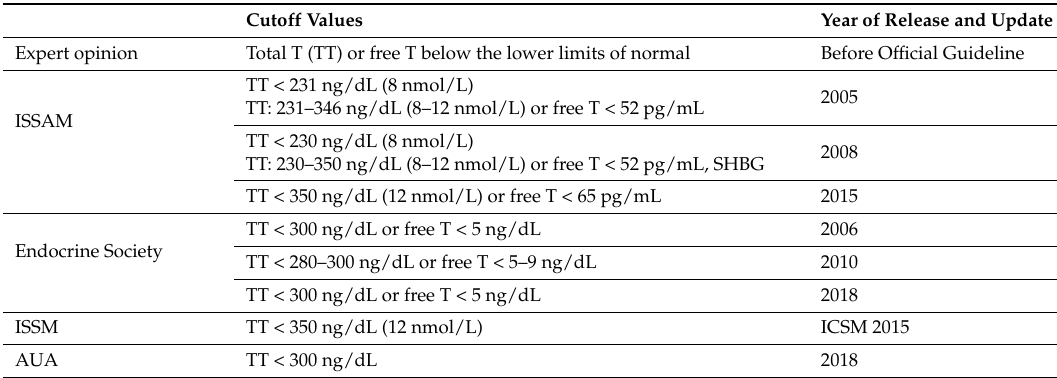
Table 4. Cutoff values of testosterone for laboratory